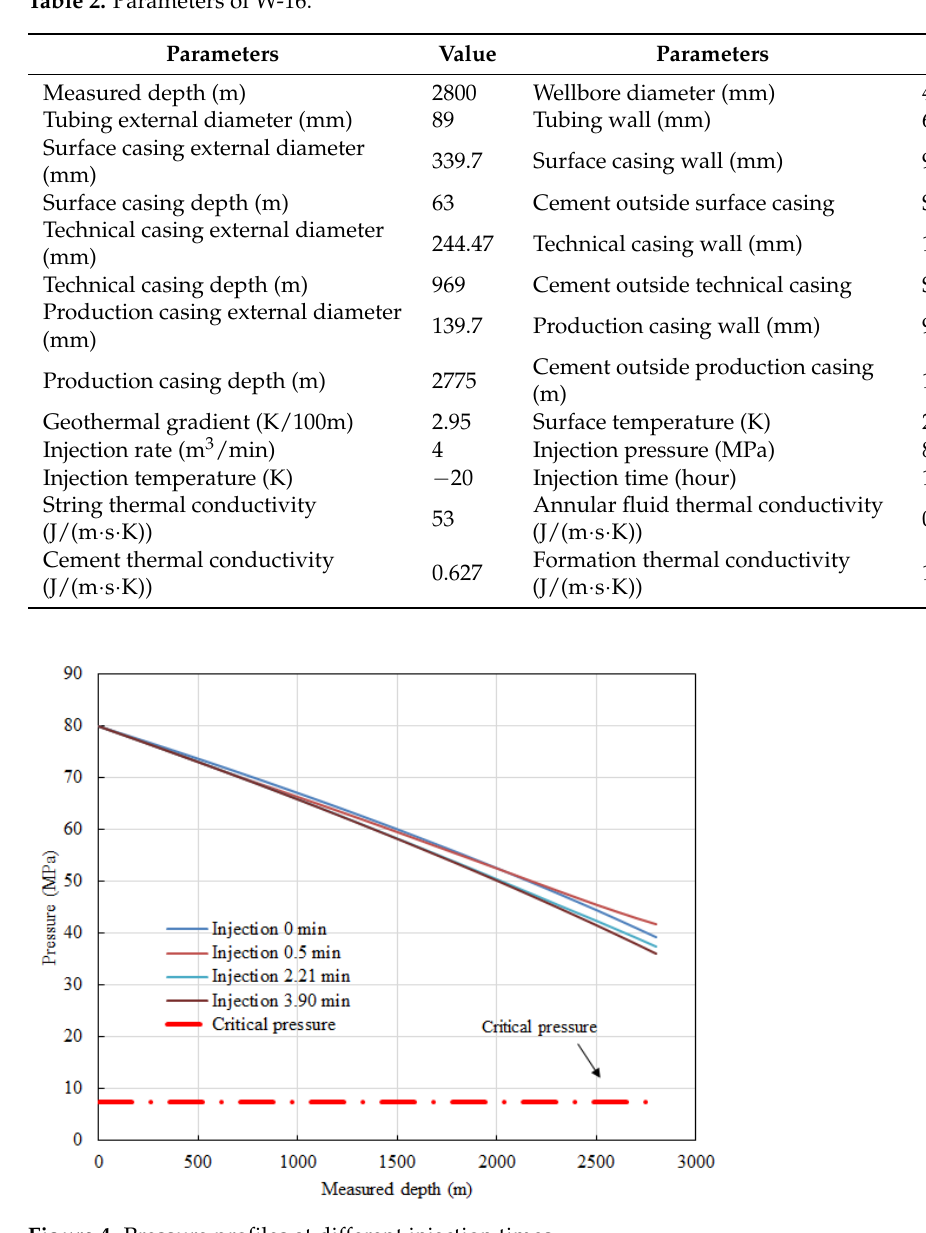
Figure 3. The measured and simulated data of Cao-8 in the second test.